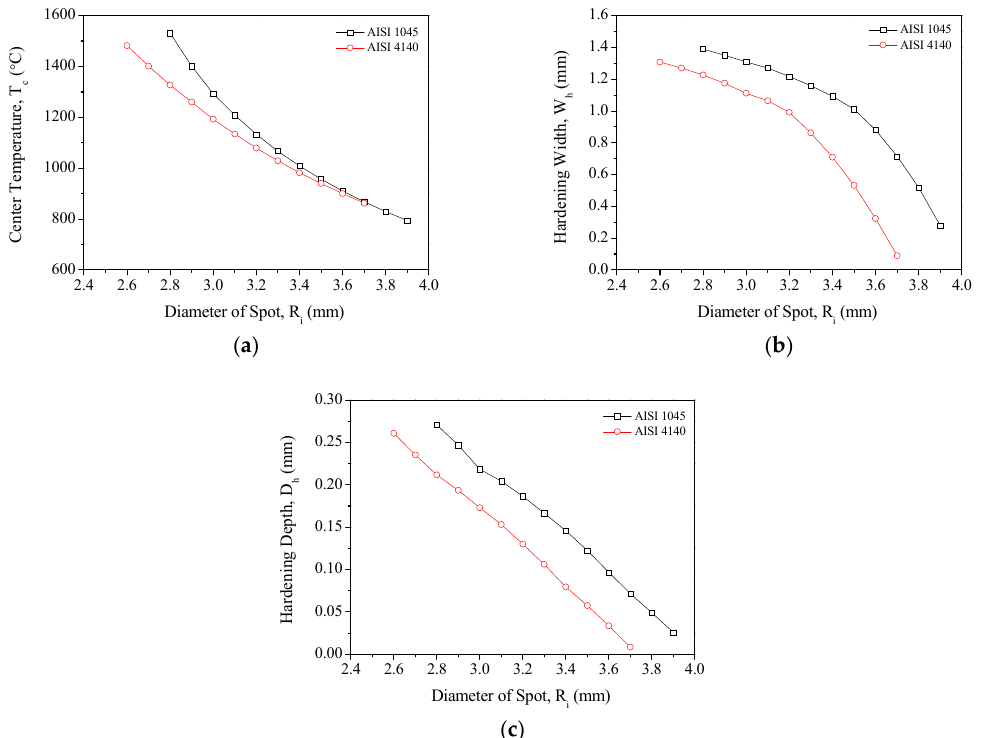
Figure 16. ( a ) Relationship between laser spot size and T c during single-track laser heat treatment; ( b ) relationship between laser spot size and hardening width during single-track laser heat treatment; and ( c ) relationship between hardening width and laser spot size during single-track laser heat treatment.